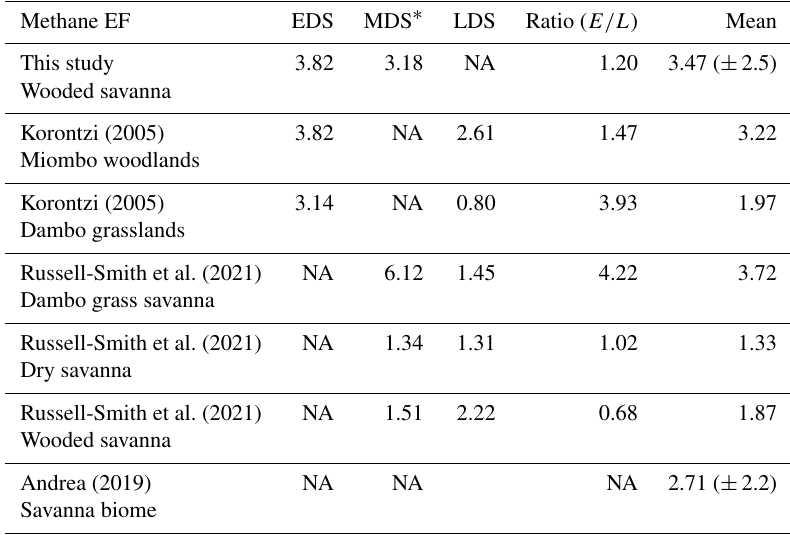
Table 3. A comparison of methane EF values for seasonal savanna and woodland fire studies.